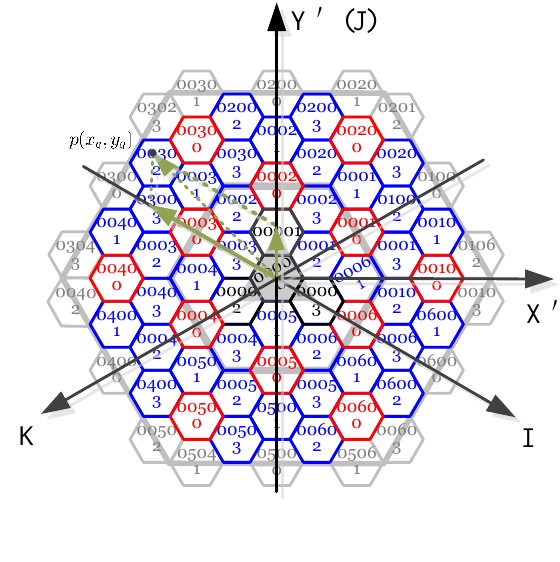
Figure 5. Conversion from geographic coordinates and location